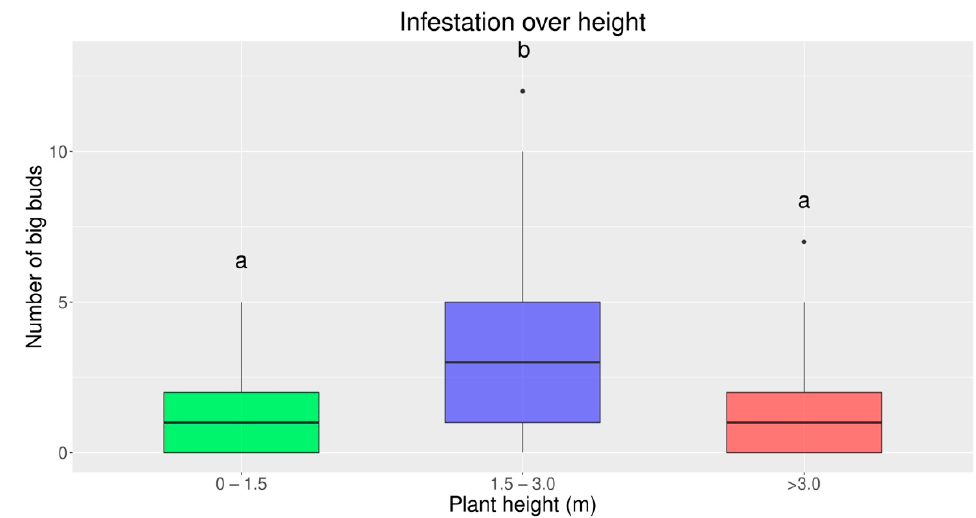
Figure 3. Overall infestation of hazelnut plants over the band heights, with no distinction between 2021 and 2022. Different letters indicate significant difference between the height ranges after Bonferroni post hoc test ( p <